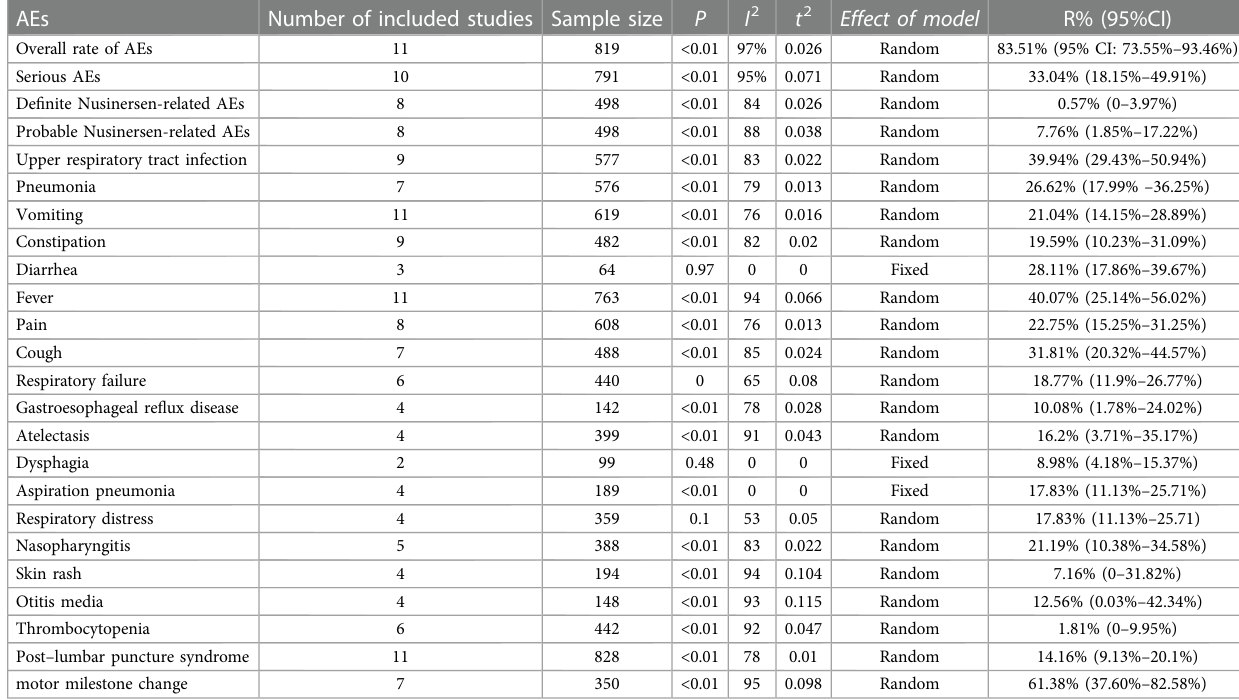
TABLE 3 Meta-analysis